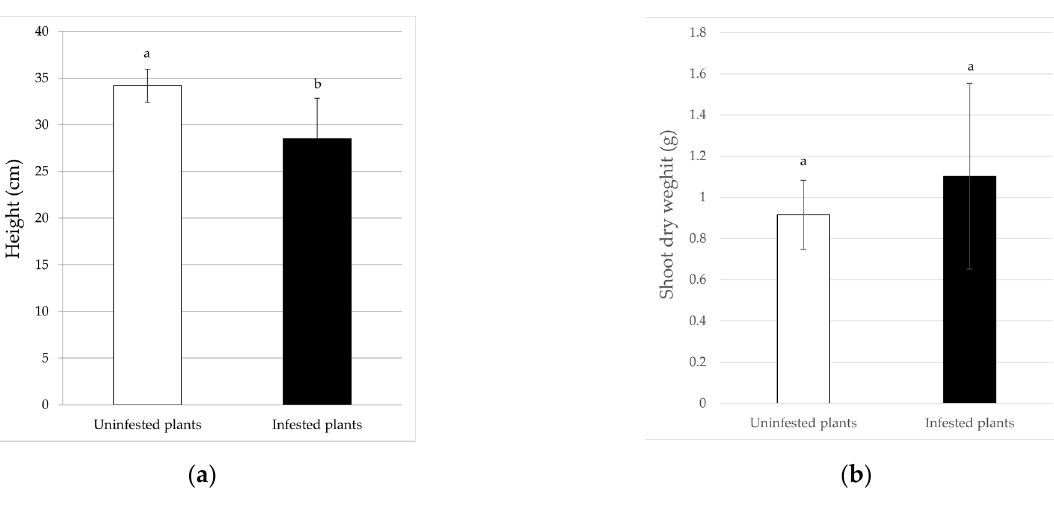
Figure 3. Effects of B. tabaci infestation on the leaf area ( a ), indirect chlorophyll content ( b ), and root dry weight ( c ) of tomato plants. Different letters indicate statistically significant differences at p < 0.05 ( a ) and p < 0.01 ( b ).